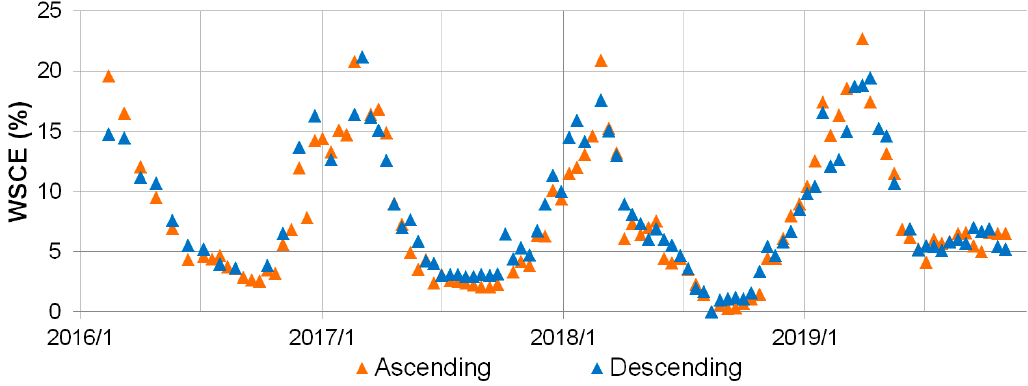
Figure 8. The estimation of the wet snow-covered extent (WSCE) percentage of the Lake Urmia watershed using ascending and descending Sentinel-1 SAR imagery.